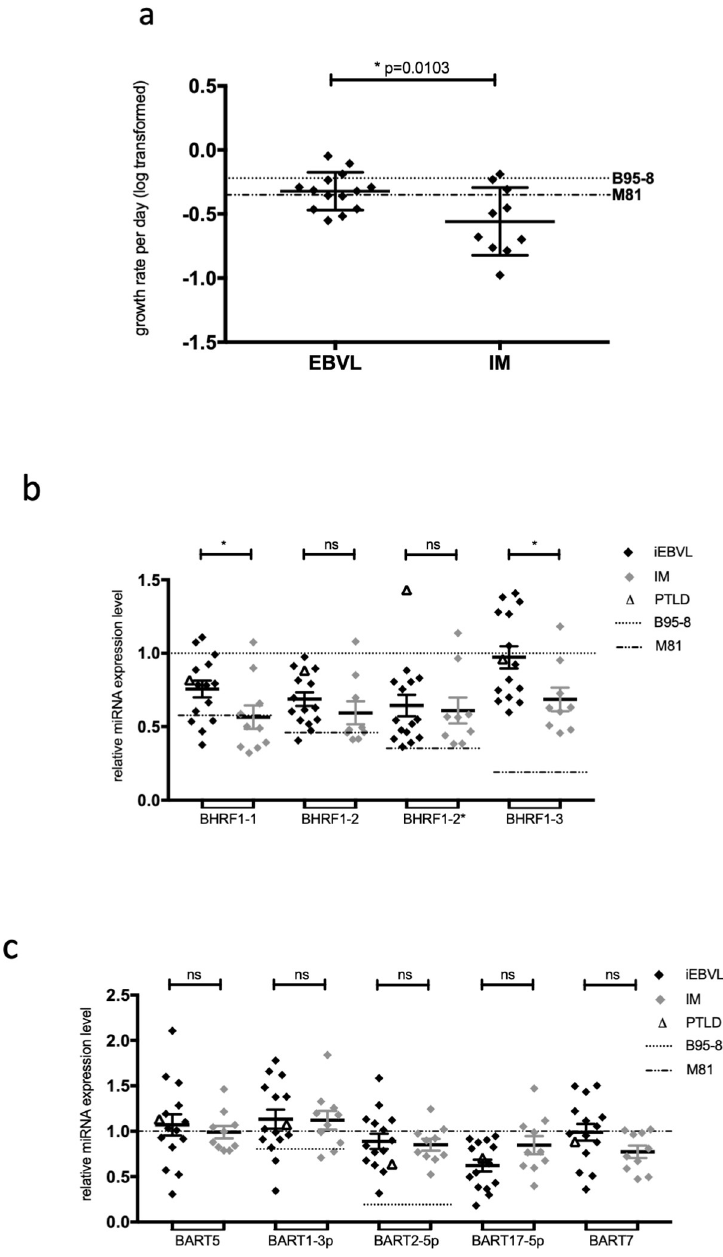
Fig 5. sLCLs from transplanted patients with iEBVL display higher growth rates and higher levels of miR-BHRF-1 and miR-BHRF1-3 compared to sLCL from IM patients. (a) The dot plots compare the growth rates of sLCLs isolated from transplant recipients with iEBVL or IM patients. The results of the statistical analysis are also given. (b and c) The dot plots compare the expression of the BHRF1 miRNAs and of some BART miRNAs in sLCLs isolated from transplant recipients with iEBVL or IM patients. The results of the statistical analysis are also